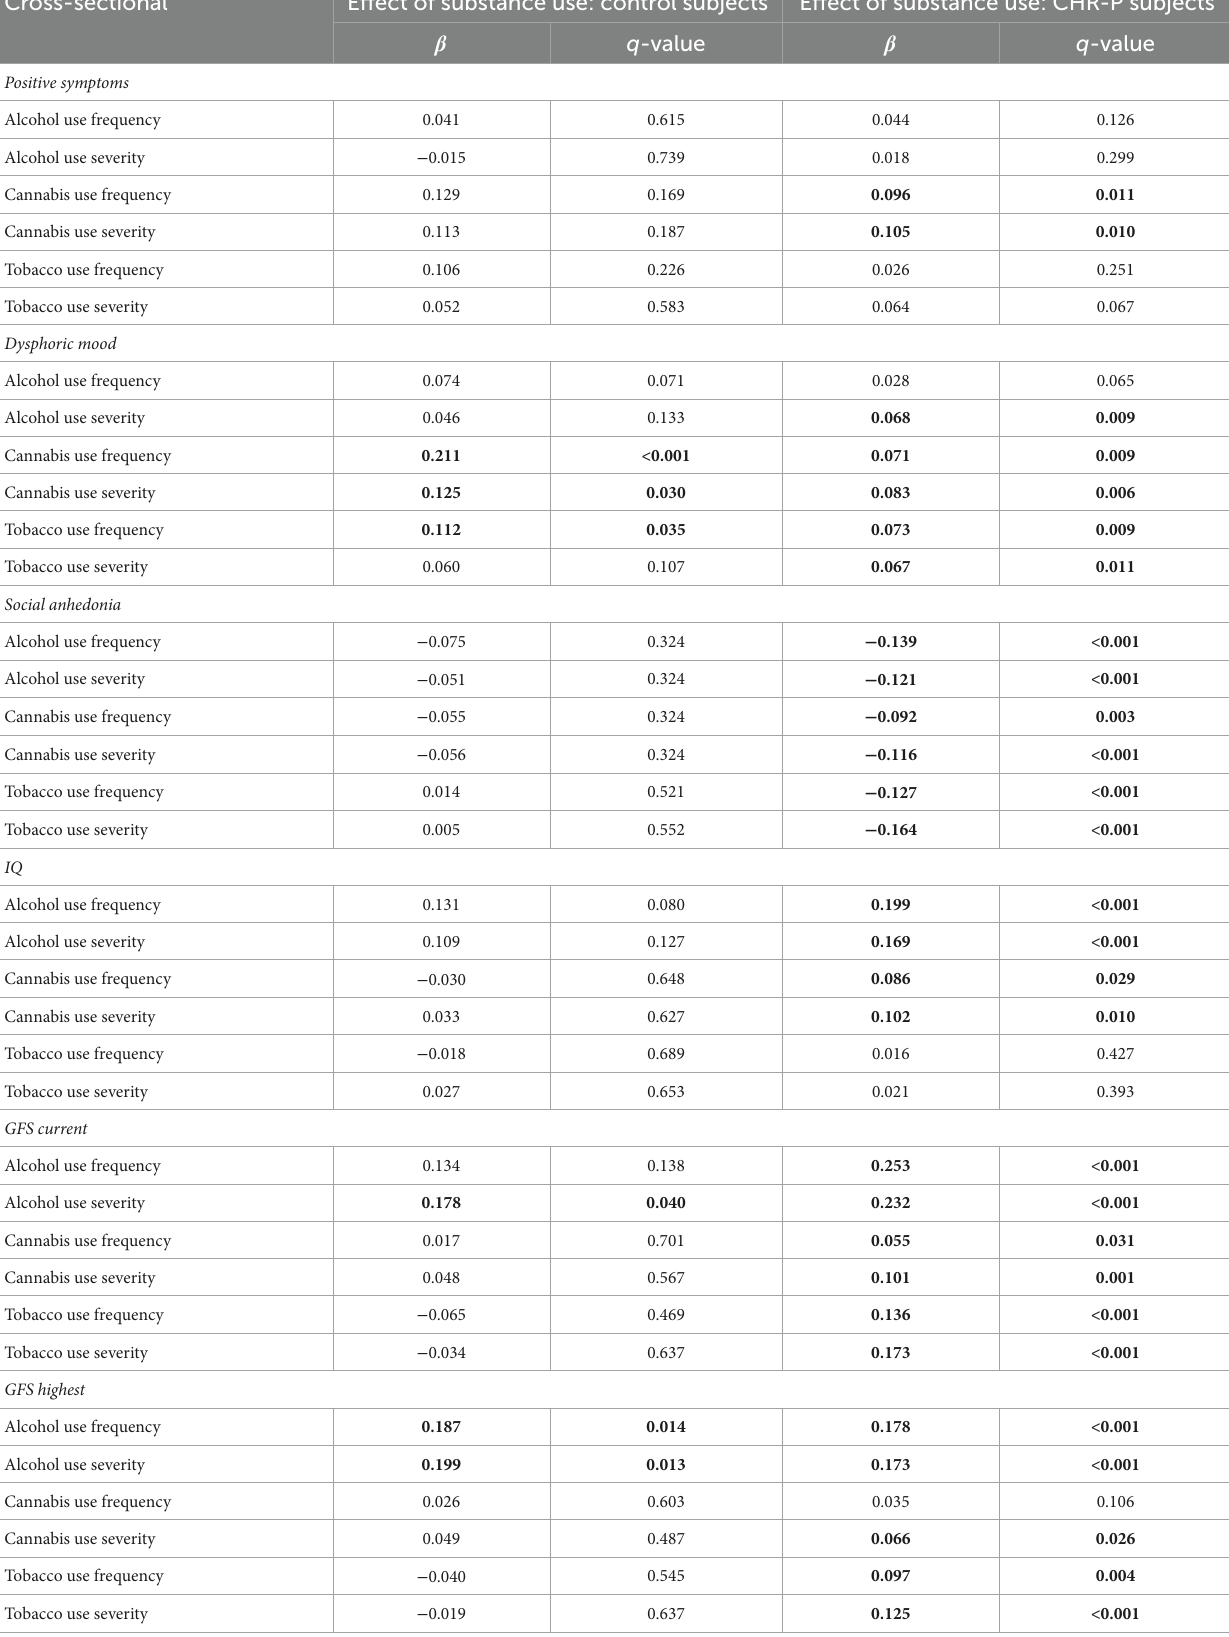
TABLE 3 Results of cross-sectional models in NAPLS 2. Cross-sectional Effect of substance use: control subjects Effect of substance use: CHR-P